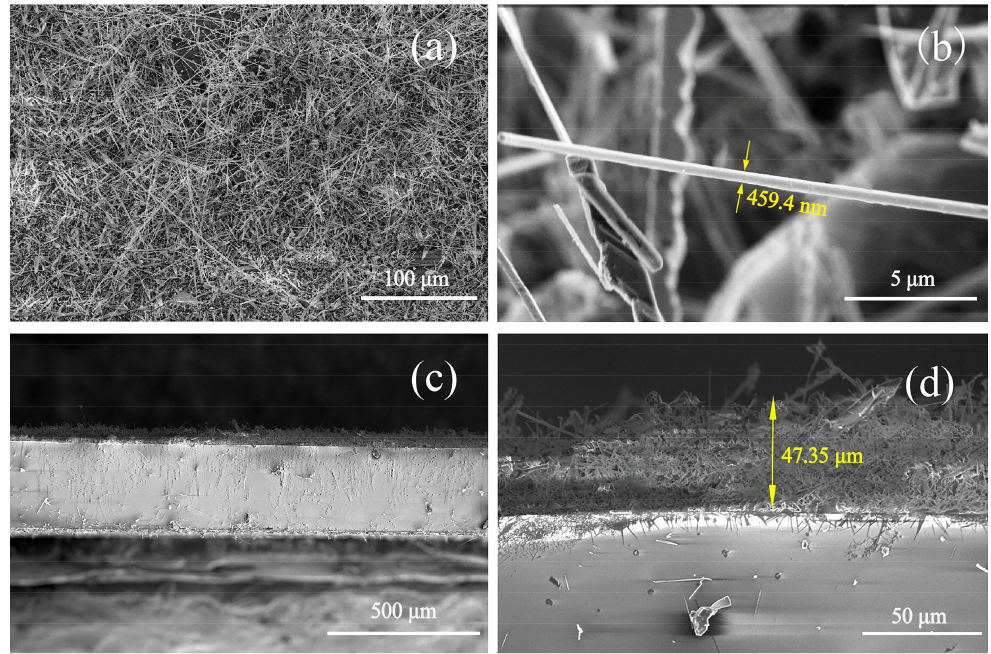
Figure 3. ( a ) SEM image of the large-scale AlN nanowires; ( b ) SEM image of a single AlN nanowire; and ( c , d ) cross-sectional SEM images of AlN